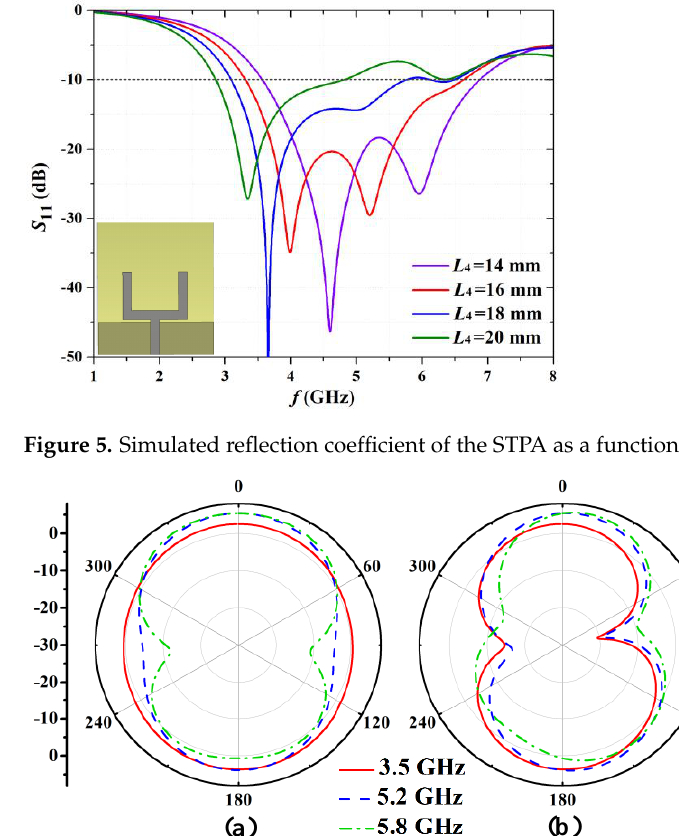
Figure 6. Simulated radiation patterns of the proposed STPA at ( a ) xoz -plane, ( b ) yoz -plane